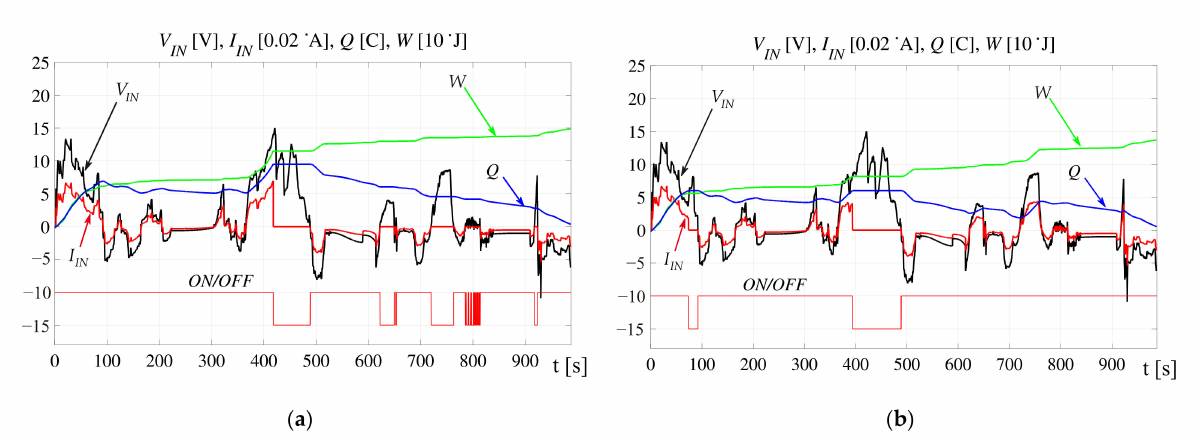
Figure 8. The results of applying charge balancing algorithms. Input voltage (black), voltage when energy was utilized (upper red), charge balance (green), charge balance when the energy was utilized (blue), the ON/OFF signal of the EH device (lower red). ( a ) EVOD: Q max = 9.5 C, W = 149 J, P av = 151 mW; ( b ) LEV: Q max = 6 C, W = 137 J, P av = 139